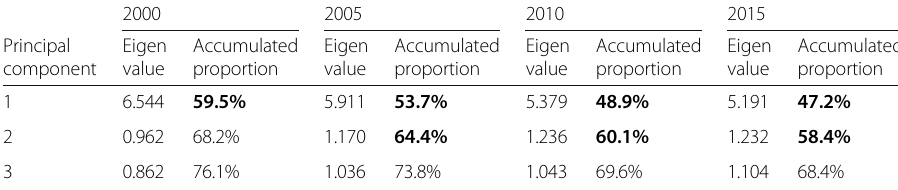
Table 2 Results for the first two principal components for SLI-C. Mexico 2000, 2010, and 2015 a